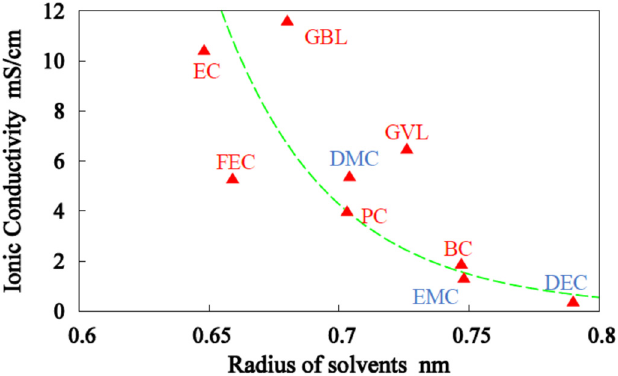
Figure 8. The correlation between the radii of solvent molecules and their ionic conductivity. The ionic conductivity is inversely proportional to the radius of the solvent, as approximated by the dashed curve.